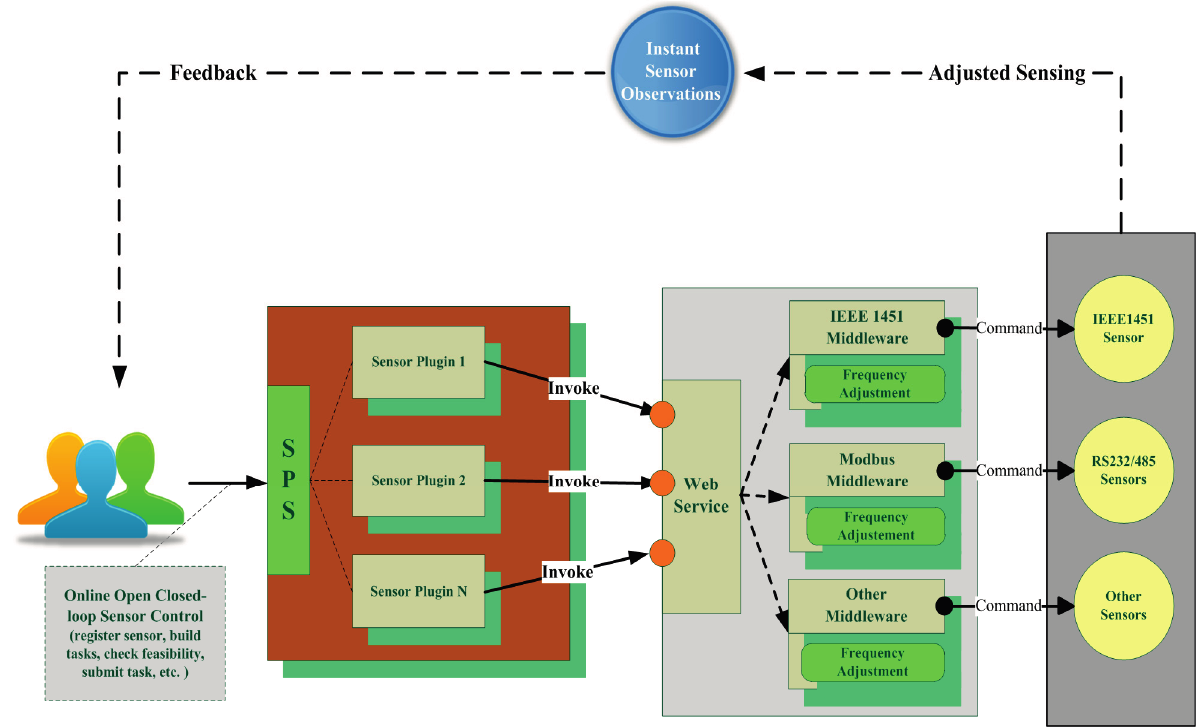
Figure 3. Open closed-loop control for diverse in-situ